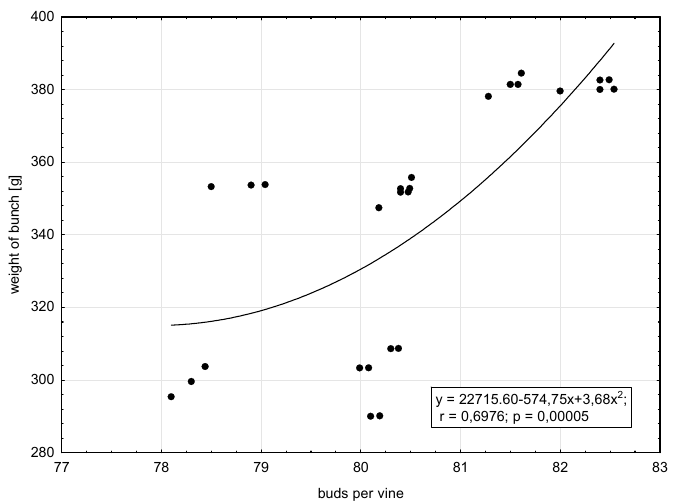
Figure 2. The effect of bud number on weight of bunches.